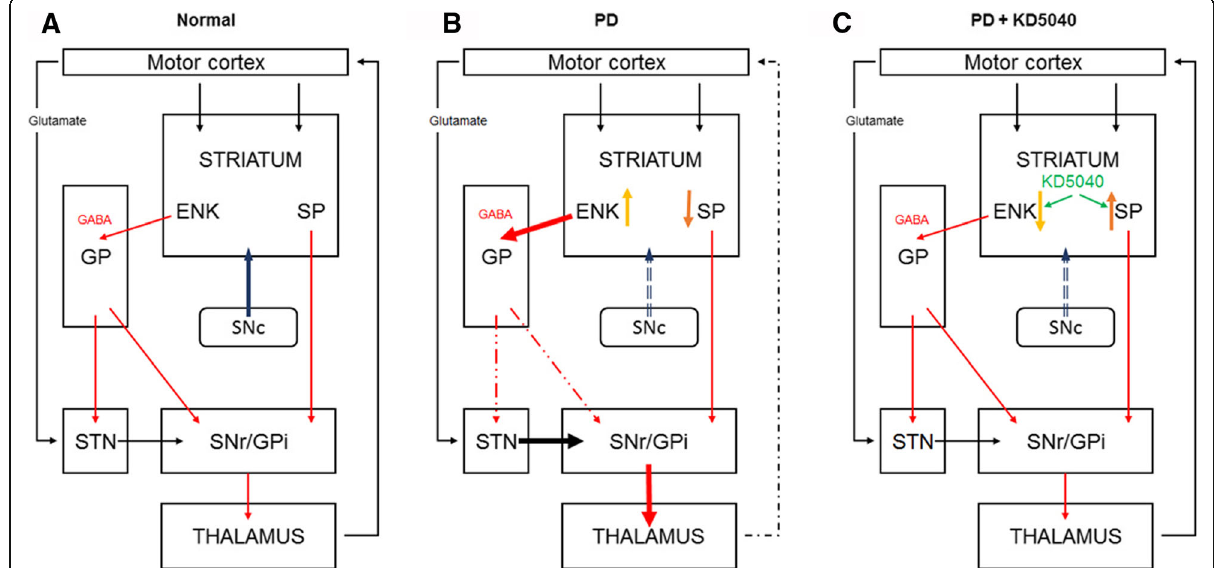
Fig. 12 Basal ganglia motor circuits in normal ( a ), PD ( b ), and combination treatment ( c ) groups. Two families of receptors, D1 and D2, mediate the actions of dopamine in the basal ganglia. The progressive loss of dopaminergic neurons in the SNc causes PD and results in an imbalance of activities between the direct and indirect pathways. However, combination treatment enhanced motor function by correcting the imbalanced activity between the indirect and direct pathways in the basal ganglia. GP: globus pallidus, STN: subthalamic nucleus, GPi: internal globus pallidus, SNr: substantia nigra pars reticulate, SNc: substantia nigra pars compacta, PD: Parkinson ’ s